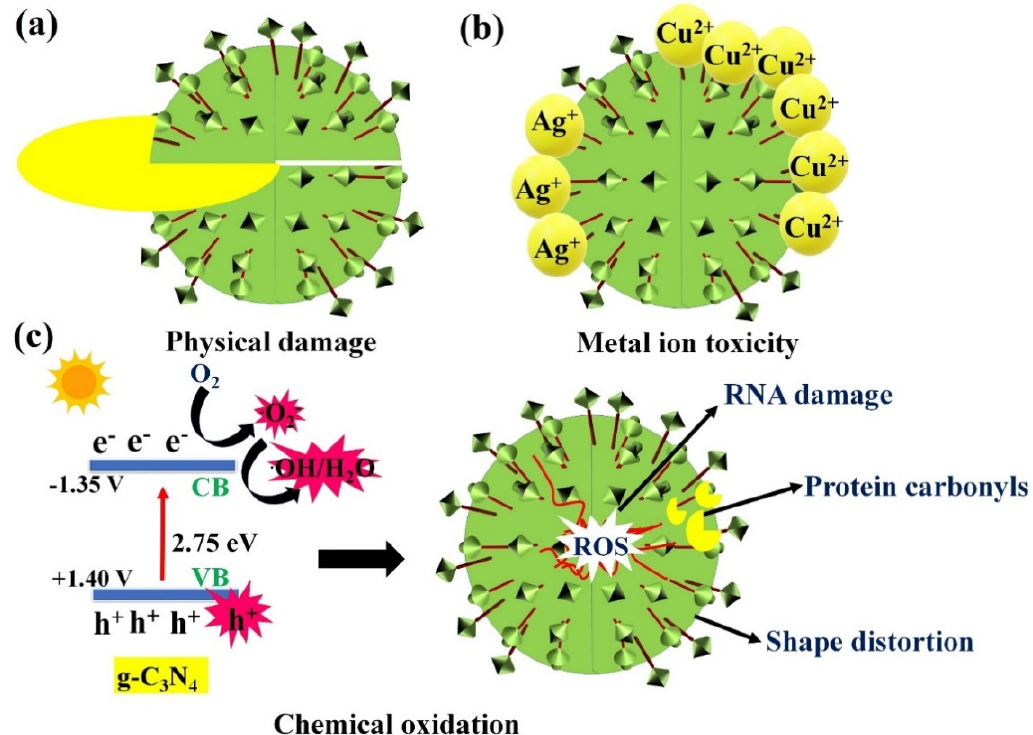
Figure 1. Proposed mechanisms of viral inactivation induced by photocatalysts via different routes ( a ) physical damage induced by rupturing of cell wall, ( b ) attack of metal ions, and ( c ) action of reactive oxidation species (ROS). Reproduced with permission from [42] with license number 5191840171112. Copyright Elsevier 2019.